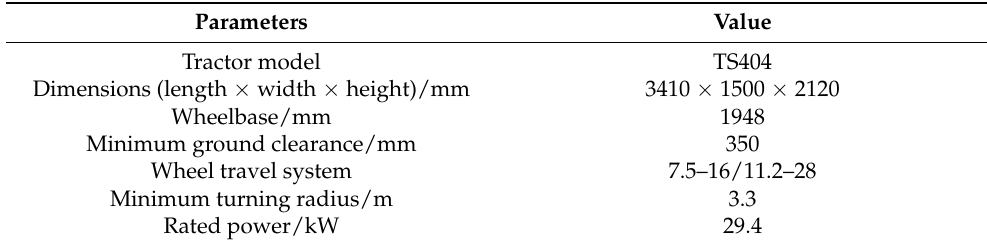
Table 2. The specifications of the tractor used in the experiment.